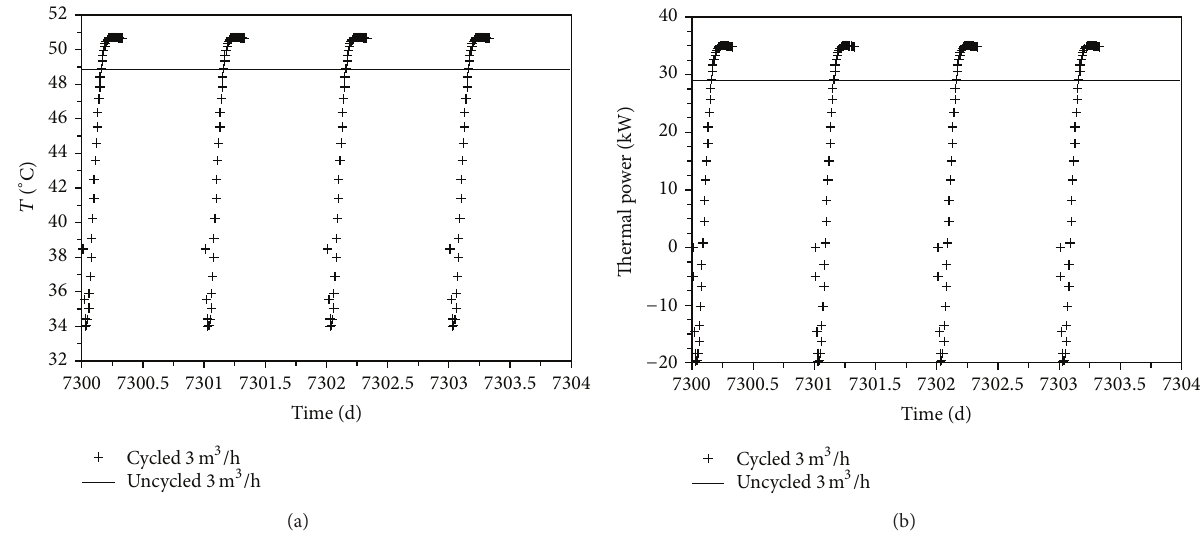
Figure 12: Production outlet temperature and associated thermal power versus time after 20 years of operation for cyclic and a continuous flow rate of 3 m 3 /h.